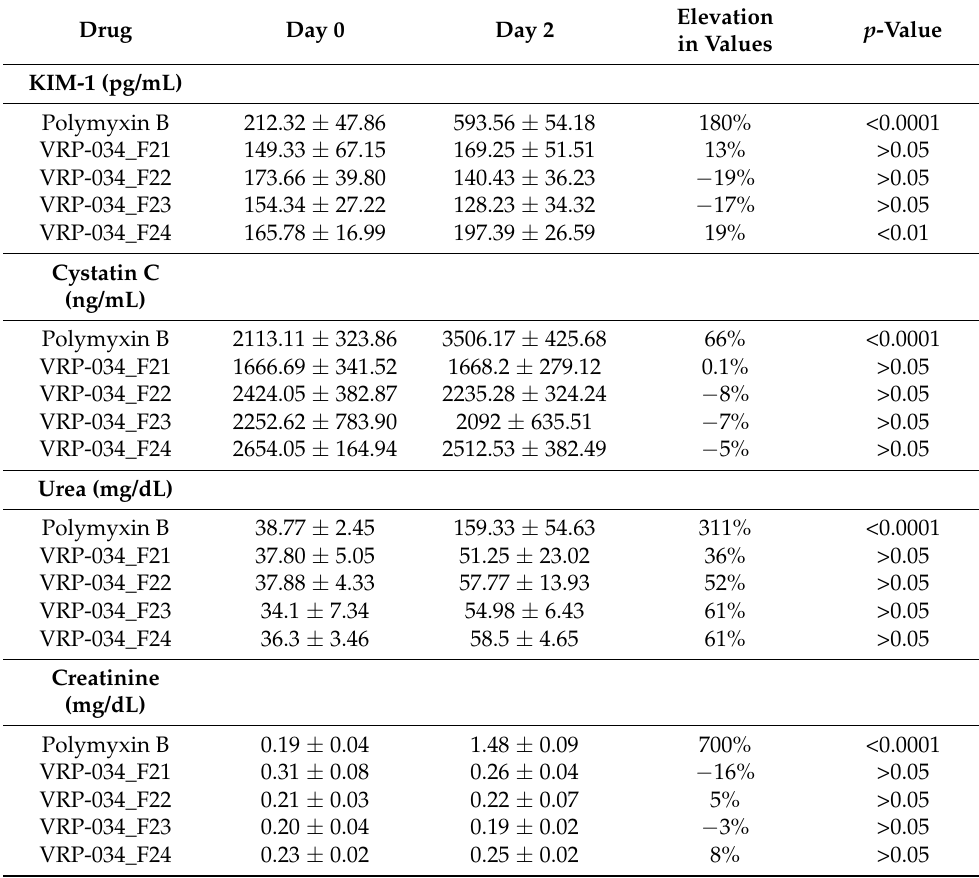
Table 1. Mean Biomarker values at Baseline (day 0) and day 2 of novel formulations (VRP034_F21–24) and Polymyxin B (Control) 1,2,3,4